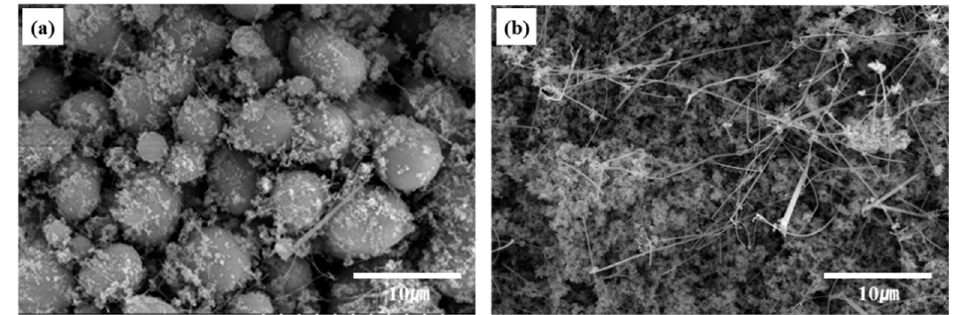
Figure 9. SEM images of the SiC powders synthesized from SiO 2 –C mixtures with C/SiO 2 ratios of ( a ) 0.5 and ( b ) 3 at 1525 °C for 1 h. The powder samples were heat-treated in air at 1000 °C for 1 h after reduction.